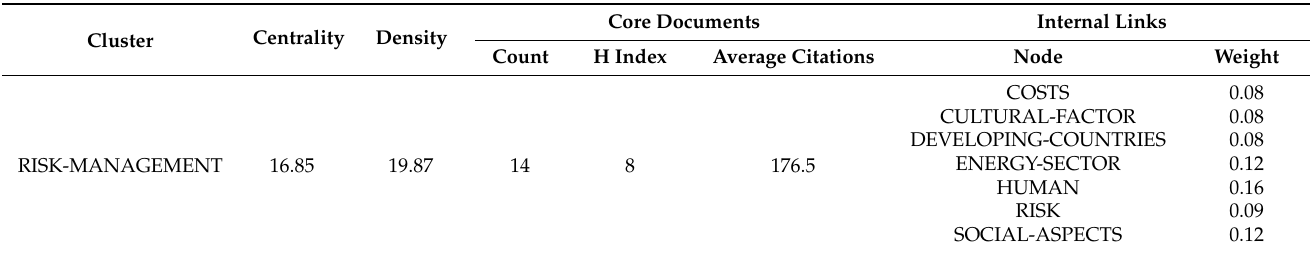
Figure 5. Major theme ( a ) and thematic network ( b ) of the first sub-period (1993–2003). Note: Cluster information: RISK-MANAGEMENT (centrality: 16.85; density: 19.87). Node size is proportional to the number of papers; the number in a node denotes the number of papers related to a node topic. See Section 2.2 for description of the quadrants. Table 4. Cluster information and key parameters—sub-period (1993–2003).